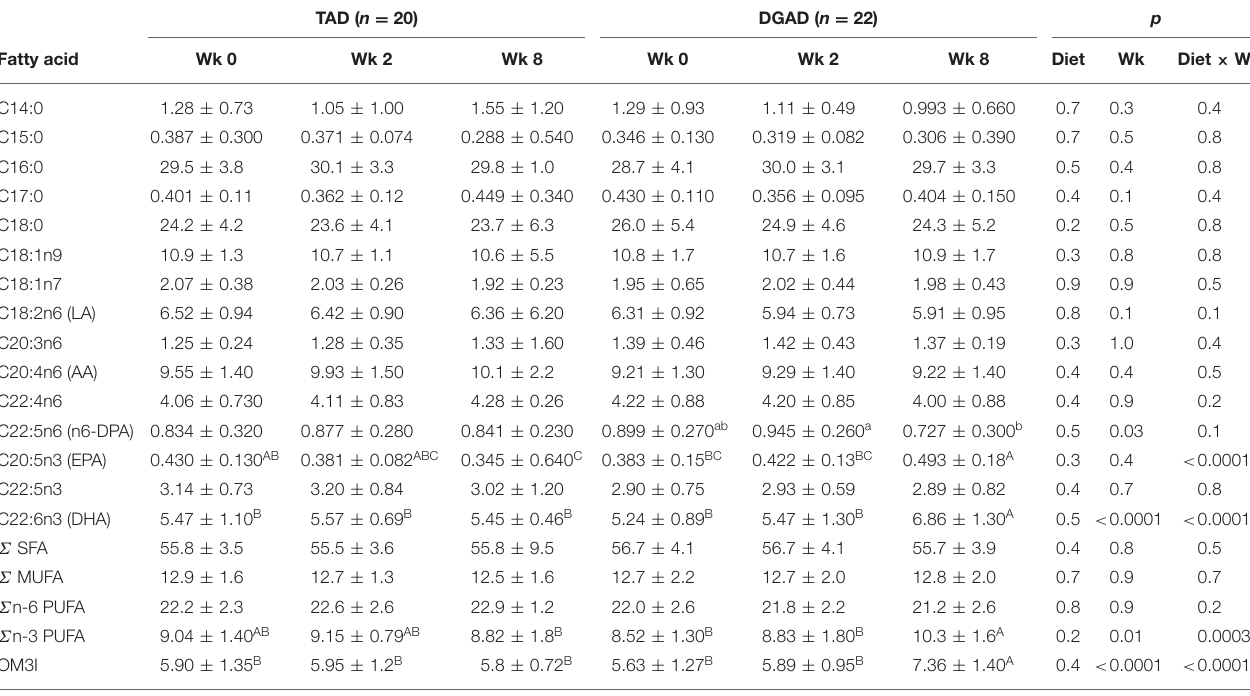
a All values are means ± SD. Treatment effects on RBC fatty acids were tested using least squares regression models incorporating diet, time, and diet x time interactions controlling for participant as a random effect with Tukey HSD post-hoc tests. For each fatty acid residue, values within diet groups with different superscripts are different at α = 0.05. If significant diet × time interactions were detected, changes are annotated with uppercase letters. TAD, typical American diet; DGAD, Dietary Guidelines for Americans diet; OM3I, omega-3 index; AA, arachidonic acid; n6-DPA, docosapentaenoic acid; ALA, alpha-linolenic acid, EPA, eicosapentaenoic acid; DHA, docosahexaenoic acid; LA, linoleic